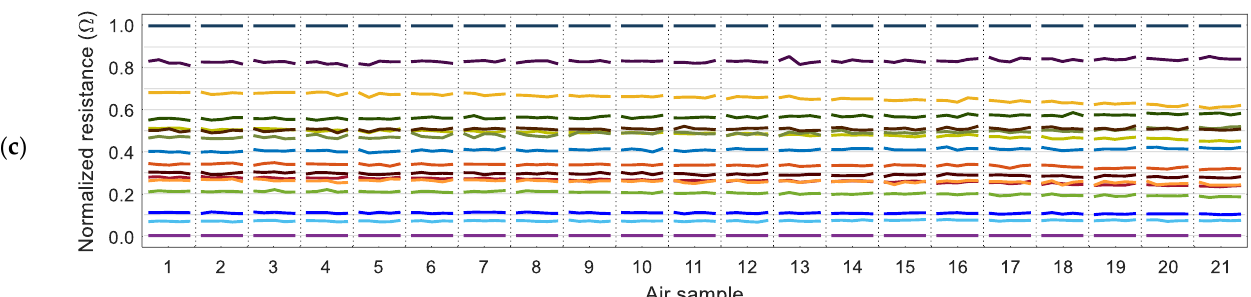
any any volatile).